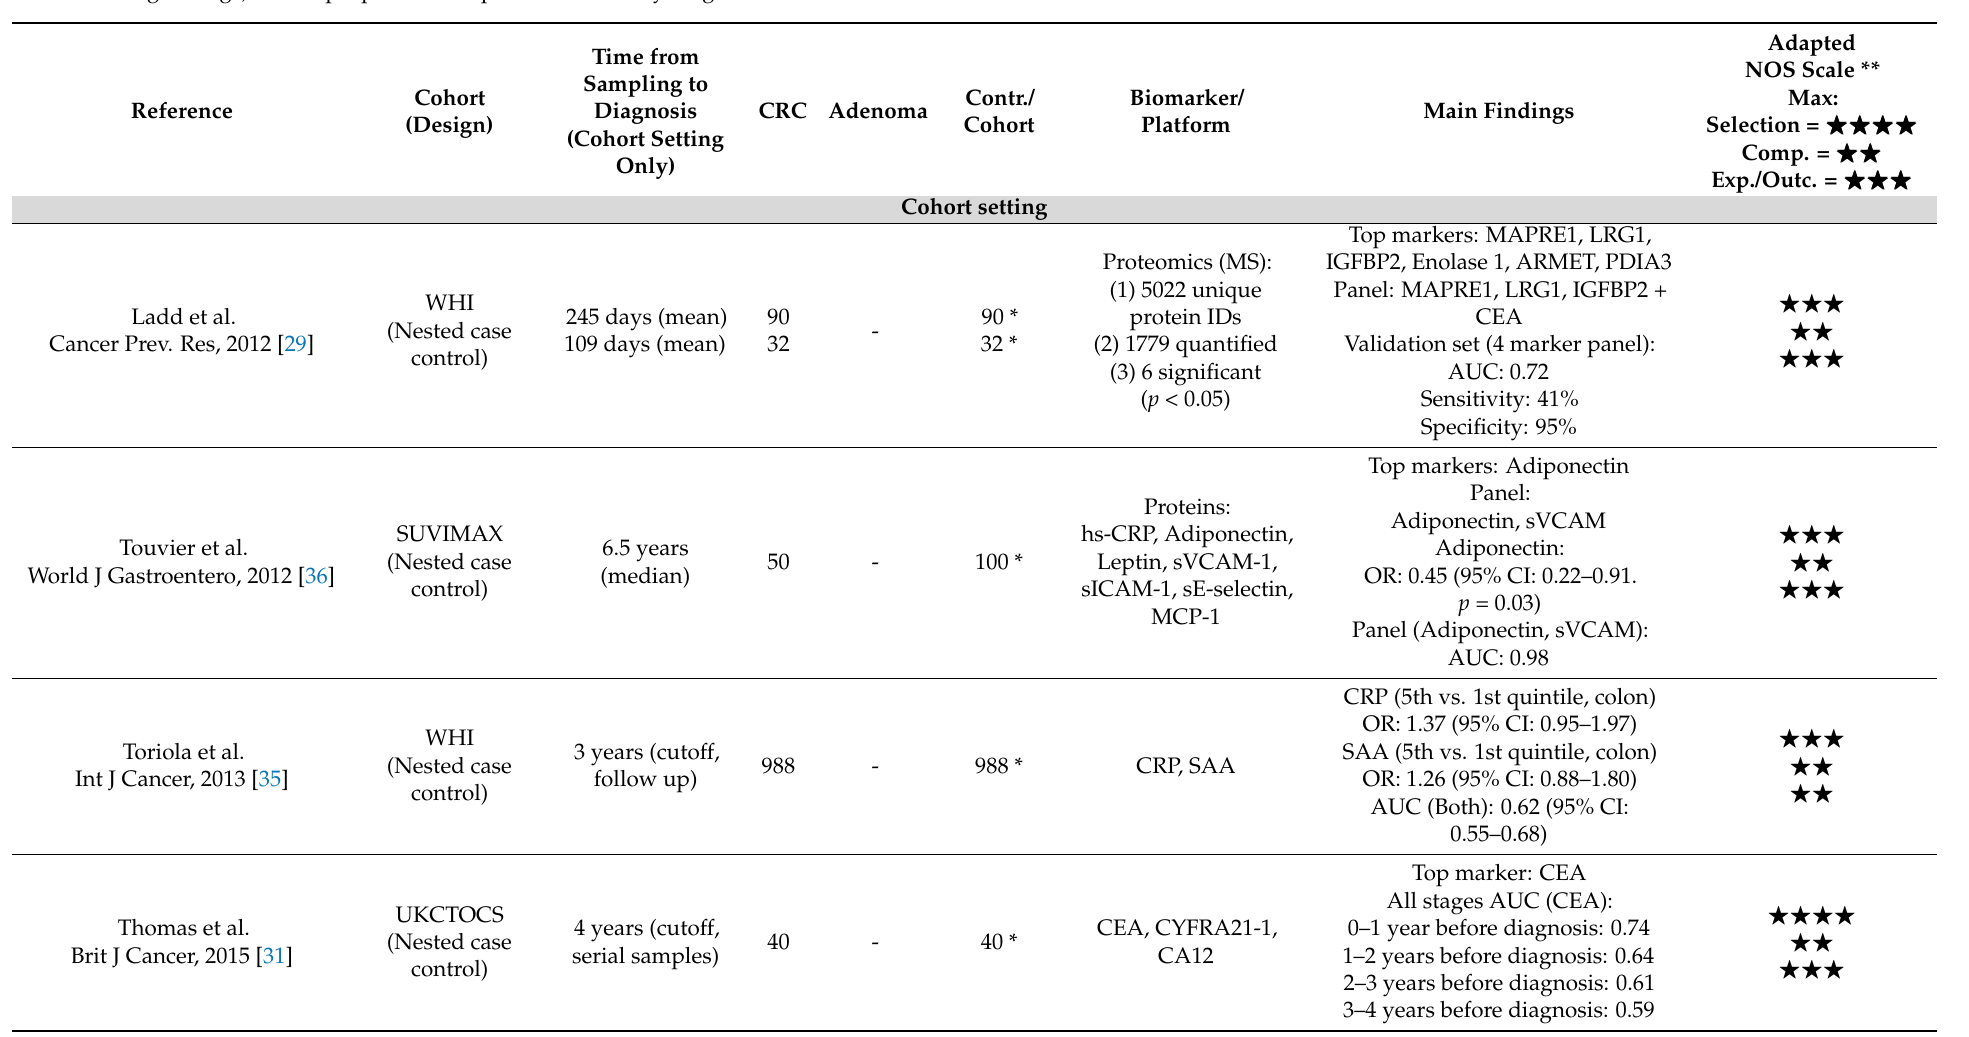
Table 1. Studies of inflammatory markers and other proteins, sometimes supplemented by antibodies, analyzed in pre-diagnostic blood samples (collected in prospective cohort or general screening settings) for the purpose of risk prediction or early diagnosis of colorectal